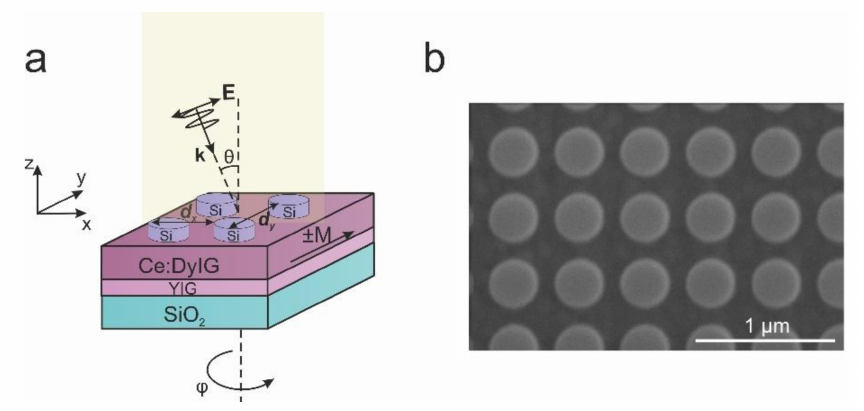
Figure 1. Schematic representation of the magneto-optical metasurface of Si nanodisk array on a Ce:DyIG ( a ) and SEM image of the sample ( b